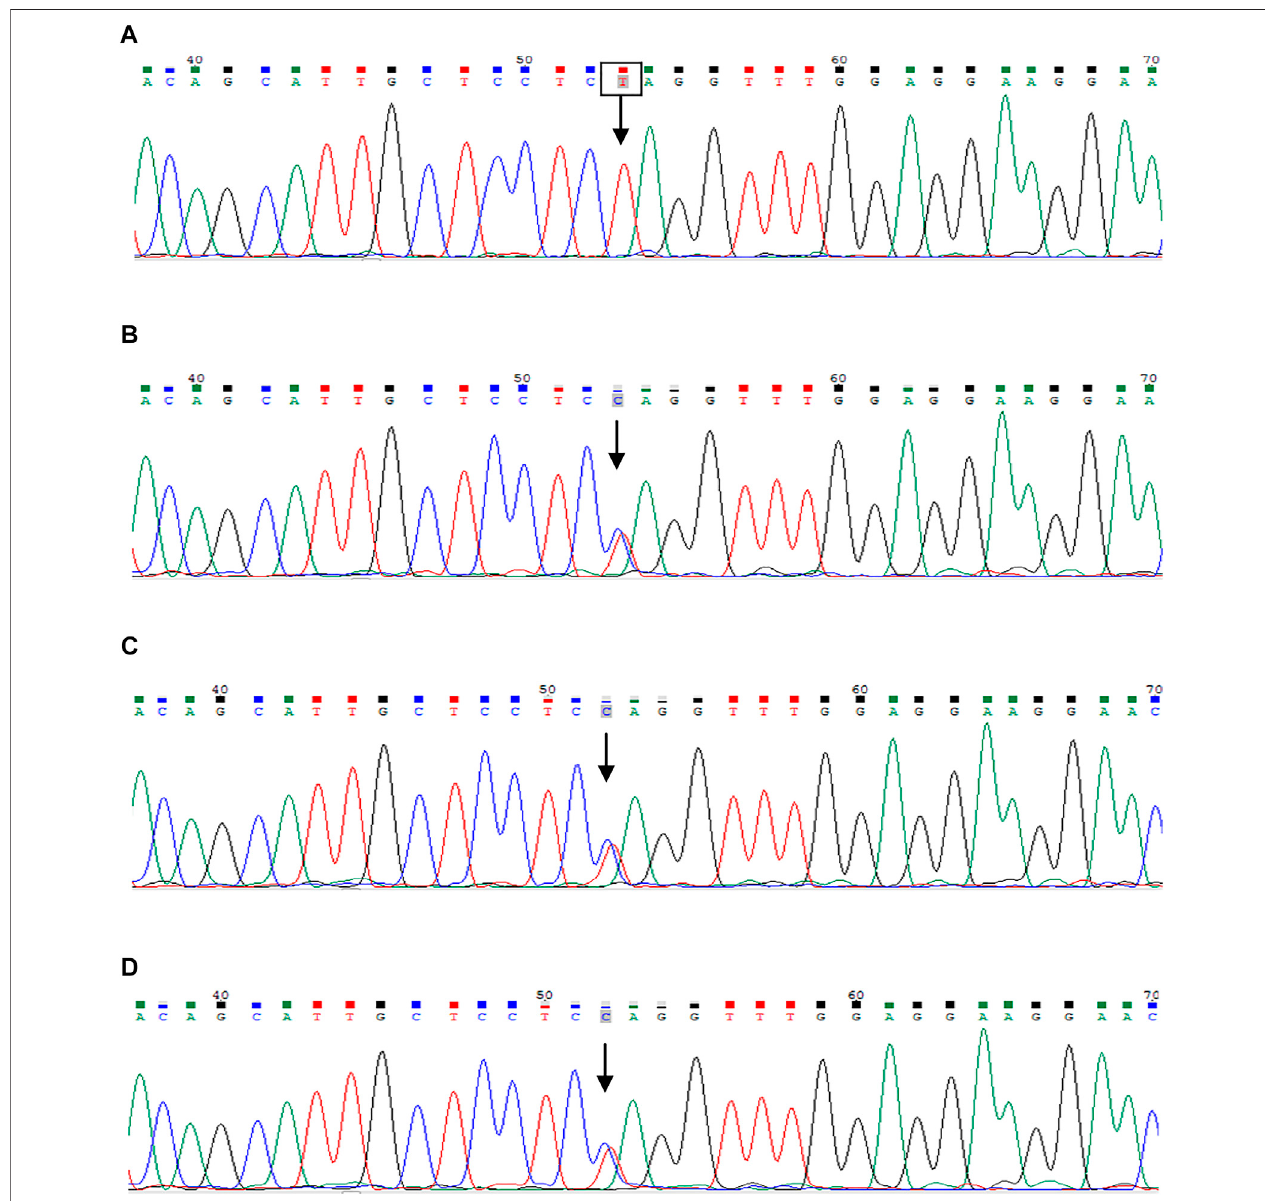
FIGURE 3 | Sanger sequencing of the INVS gene. The patient was identi fi ed with 1-bp substitution; (C) C1909T, NM_001318382, Chr9:103059299 (A) . His parents and younger brother are heterozygous carriers (B – D) , and the arrows show the position of the mutation.